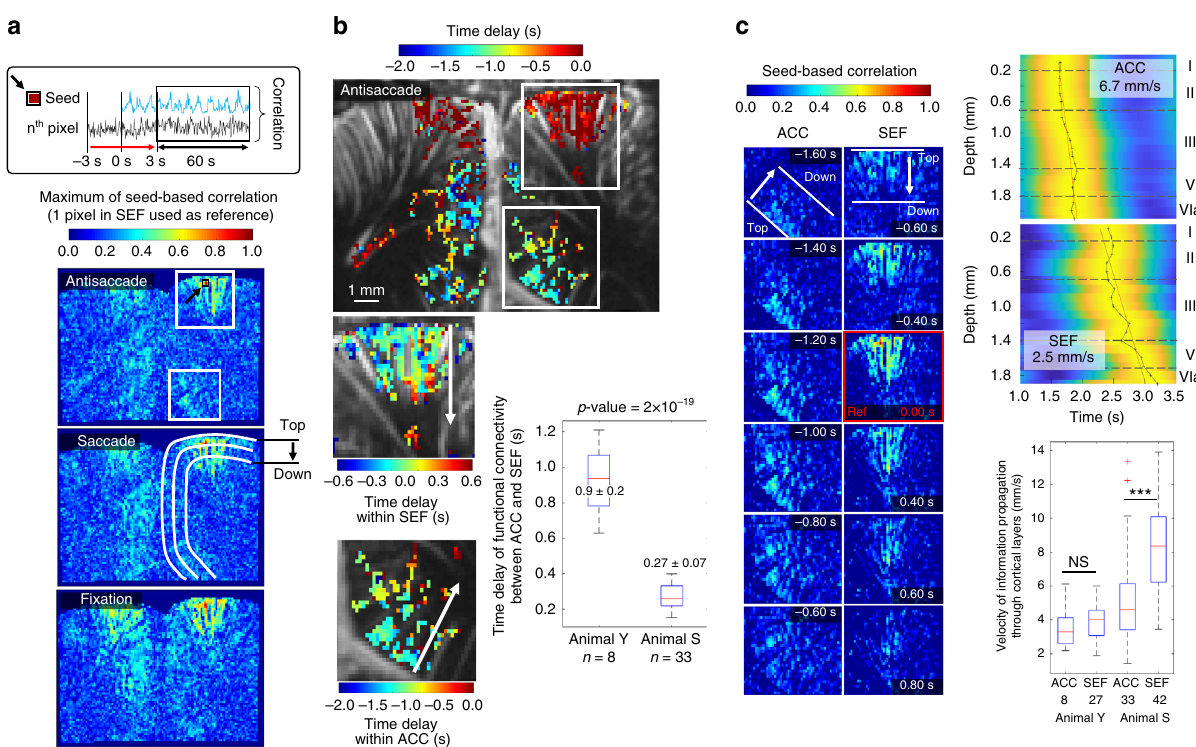
Fig. 4 fUS permits access to the directional functional connectivity of cortical layers. a Time delays between and within the ACC and SEF were extracted from a seed-based correlation map for pixels with a correlation above 0.3 (a reference pixel in the SEF was chosen based on the highest variation in CBV over the experiment). b The average time delay of information propagation between the ACC and SEF was 1.0 ± 0.3 and 0.26± 0.08 s for animals Y and S, respectively. c Thanks to the temporal resolution of fUS (10 ms), it was possible to track the propagation of the correlated information within cortical layers and to compute the propagation velocity. Successive screenshots revealed a propagation of information fi rst in the ACC and then in the SEF. The reference time (screenshot with red borders) corresponds to the time when the auto-correlation coef fi cient of the 1-pixel SEF is 1. The average velocity of information propagation through the cortical layers of the ACC and SEF was, respectively, 3.6 ± 1.3 and 4.0 ± 1.2 mm s − 1 for animal Y and 5.2 ± 2.6 and 8.4 ± 2.6 mm s − 1 for animal S. NS means non-signi fi cant and results are presented as mean ± SD. The data were summarized as boxplots depicting the minimum, lower quartile, mean value (red line), upper quartile, and maximum values. *** indicates a p -value <5 × 10 − 4 for a two-sample t -test. Digits on the x -axis of the boxplot indicate the number of measurements. Cortical layers were delineated based on reference